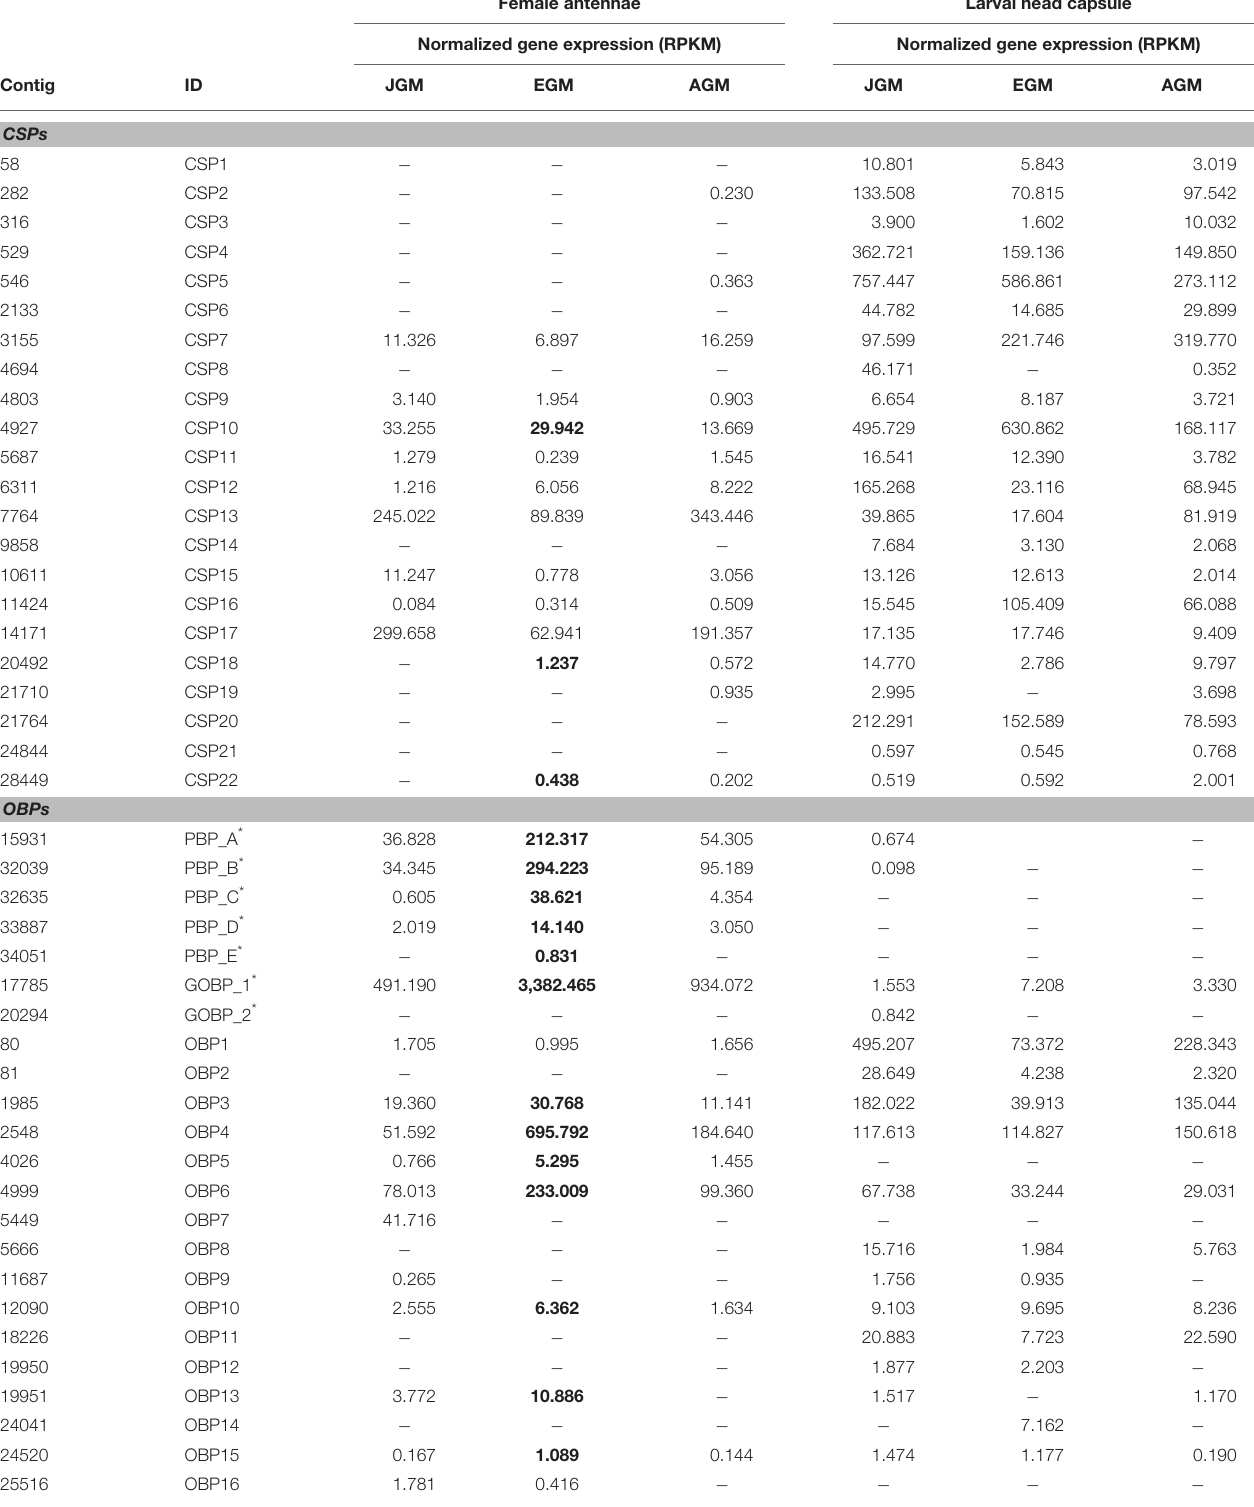
TABLE 1 | Normalized expression values (RPKM) for different families of chemosensory genes in the female antennae and larval head capsules of three populations of the gypsy moth Lymantria dispar . Female